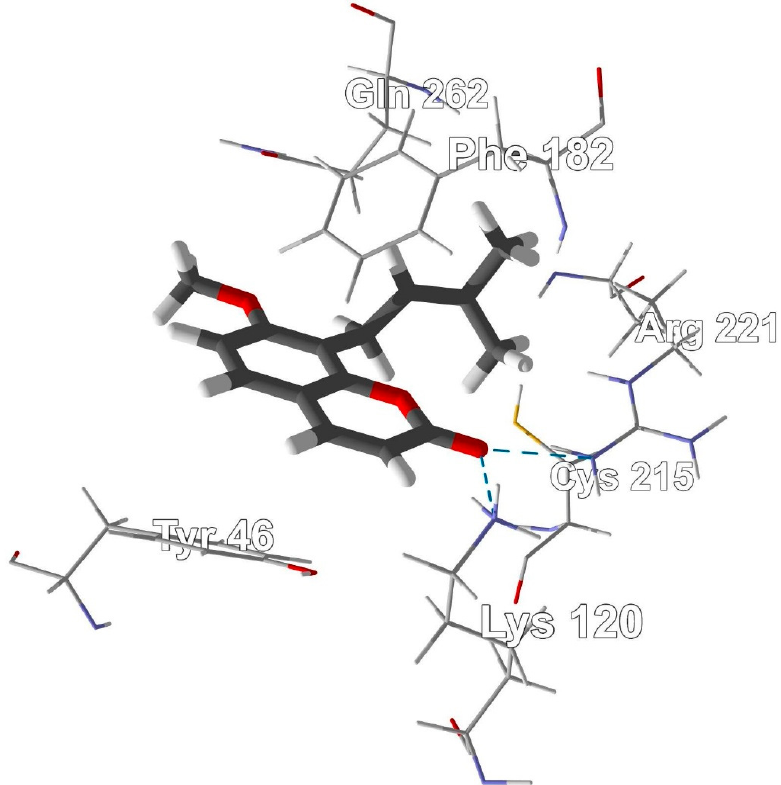
Figure 6. The active site of human protein tyrosine phosphatase 1B (PTP-1B, PDB 2HB1) with the lowest-energy docked pose of osthole. Hydrogen-bonding interactions are indicated by the blue dashed lines.